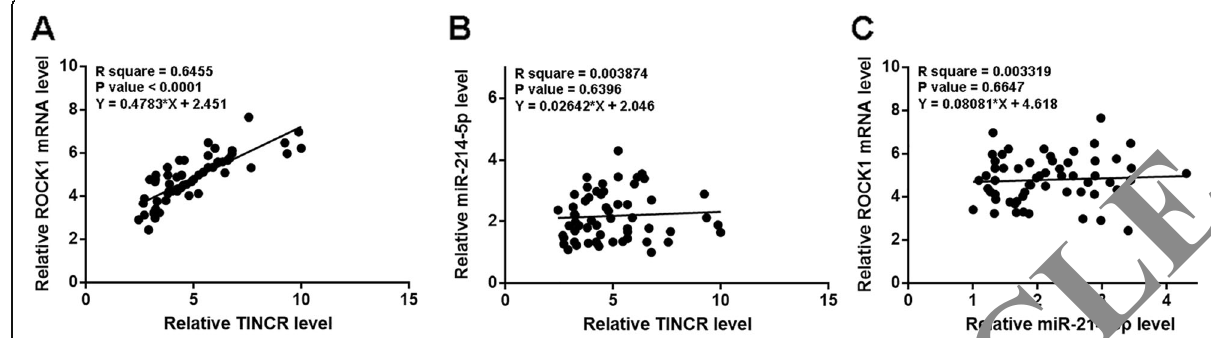
Fig. 2 The correlations among TINCR, ROCK1 and miR-214-5p in HCC. The correlations between TINCR/ROCK1 ( a ), TINCR/miR-214-5p ( b ) and miR- 214-5p/ROCK1 ( c ) were analyzed by linear regression